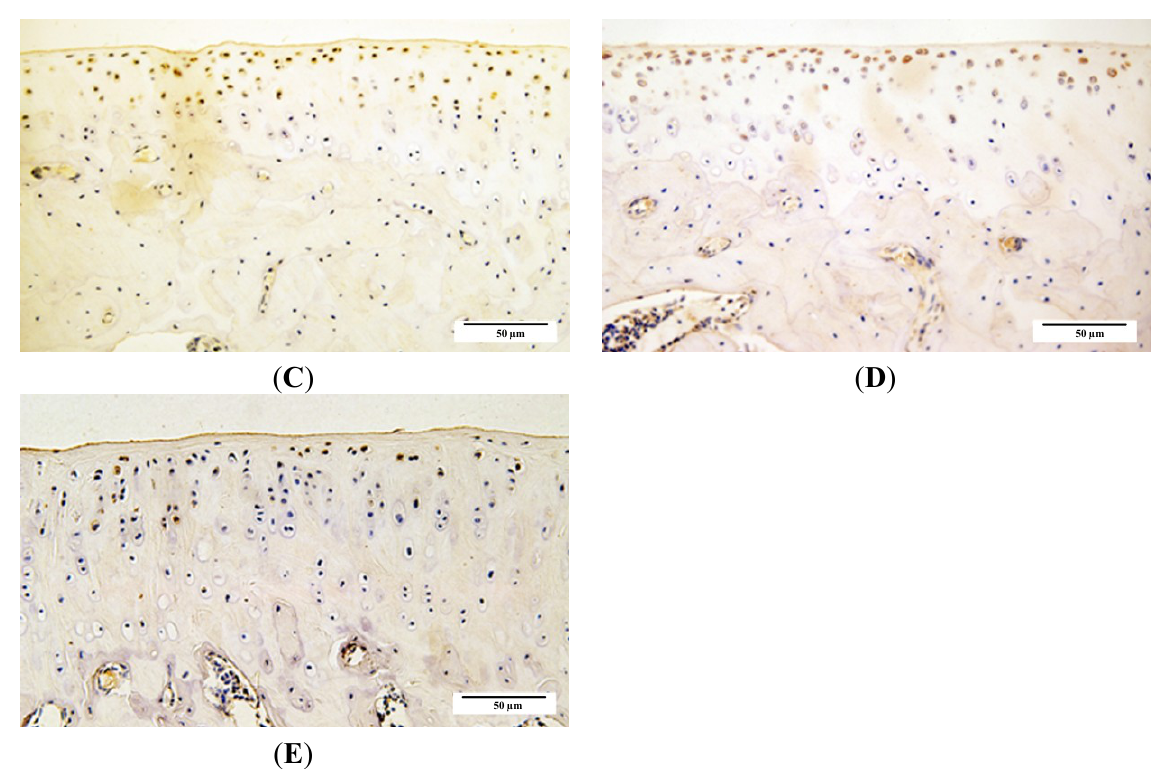
Figure 9. Immunohistochemistry assay for and matrix metalloproteinase-3 ( MMP-3) in each age group. ( A ) 1-month group; ( B ) 3-month group; ( C ) 6-month group; ( D ) 9-month group; and ( E ) 12-month